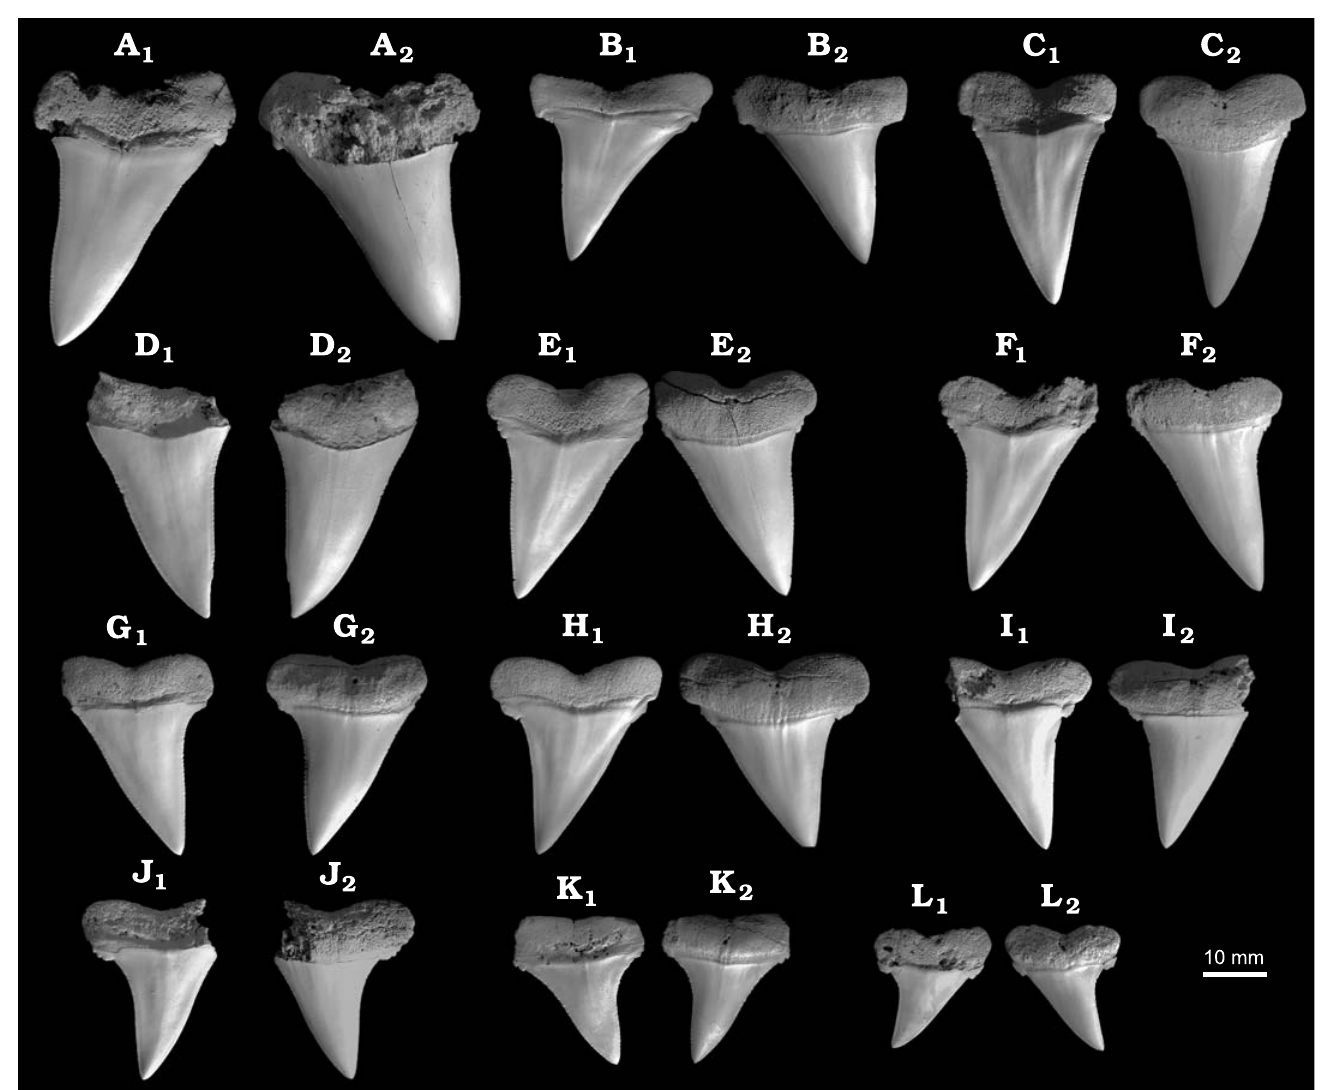
Fig. 10. Upper teeth of the mackerel shark Carcharomodus escheri (Agassiz, 1843), MNU 071-20, from Groß Pampau, the middle–late Miocene. A . Second upper right anterior tooth. B . Right upper first lateral tooth. C – L . Left (C, D, G, I, K) and right (E, F, H, J, L) upper teeth. Labial (A views. For positions of lateral teeth within jaw see Fig.